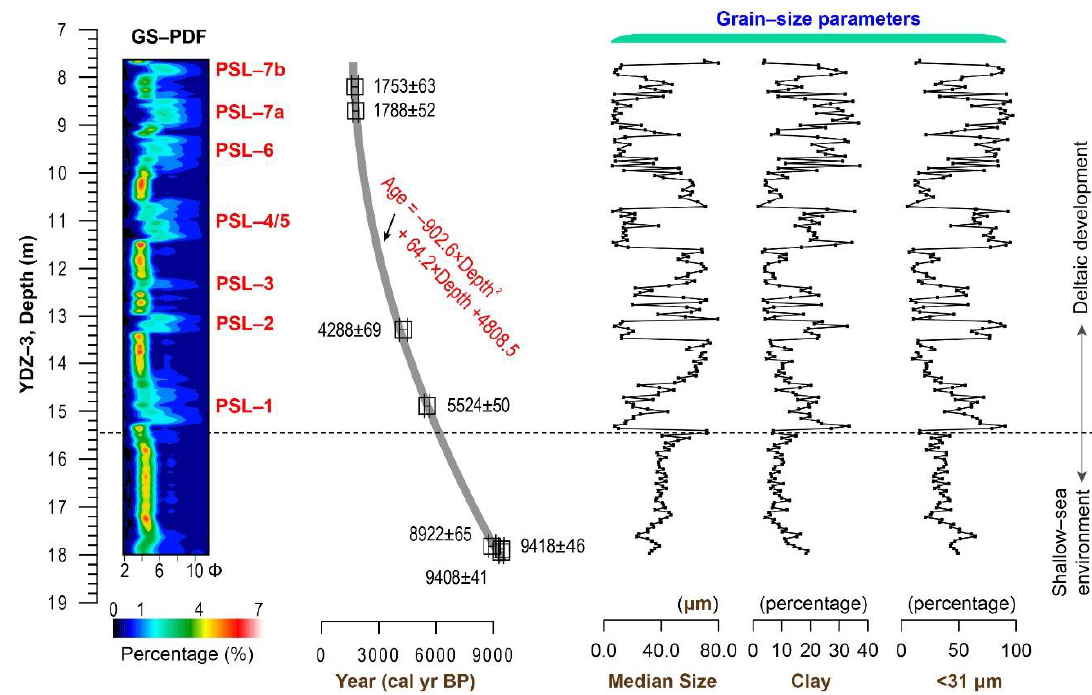
Figure 2. GS–PDF, age model, median size, clay component, and the content of grain-size < 31 μm of core YDZ–3. GS, sediment grain size; PDF, probability density function of sediment grain-size spectrum; PSL, paleo-superlobe.